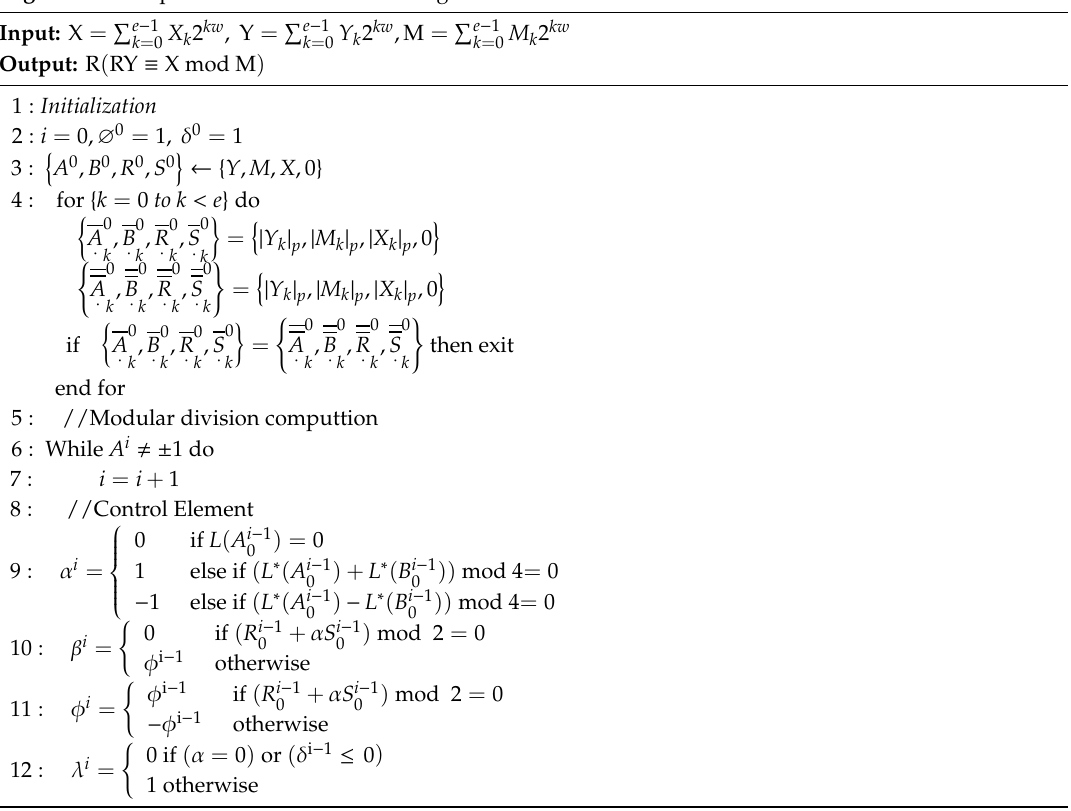
Figure 2. The proposed secure systolic architecture for the MD. Algorithm 2 Proposed word-oriented MD Algorithm with concurrent error detection